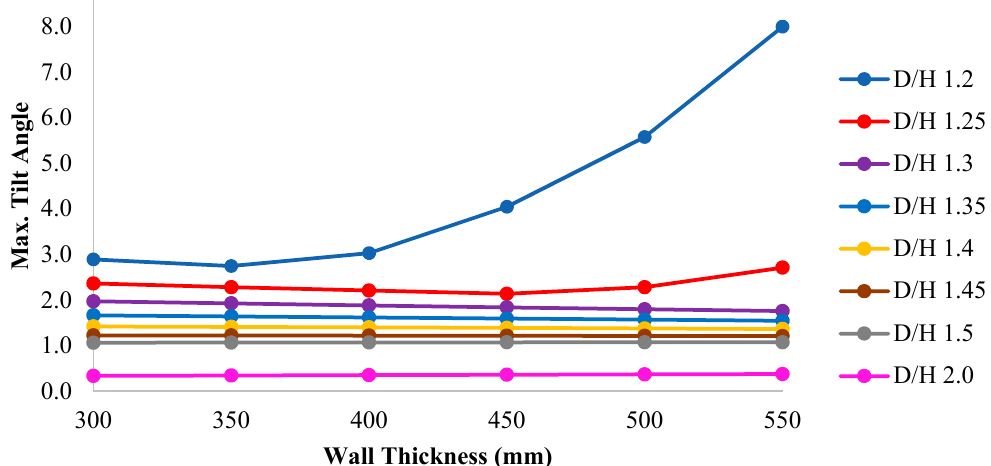
Figure 21. Effect of wall thickness on tilting angle for 15,000 m 3 tank (L/D = 1.05) under working environmental condition.